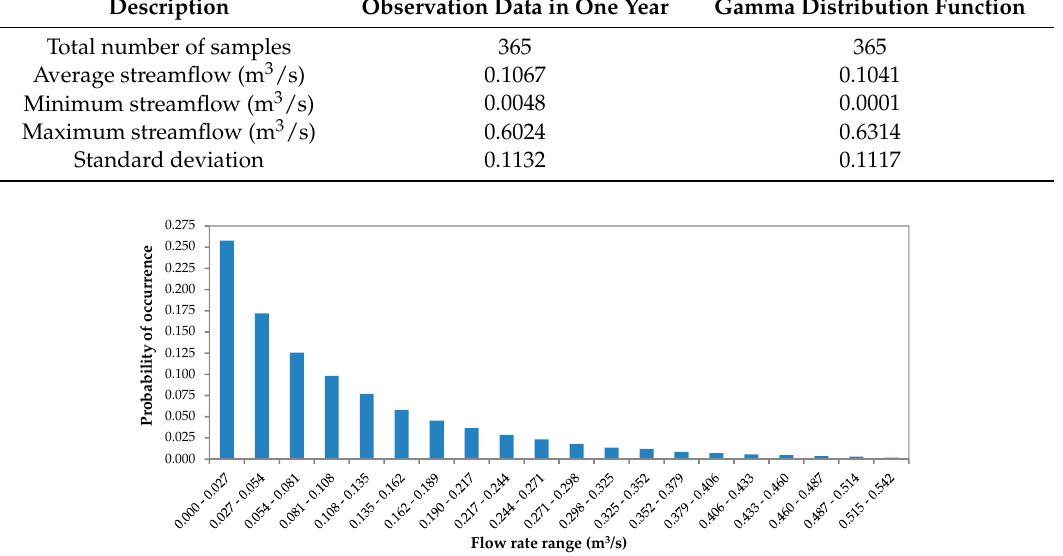
Figure 7. Probability of occurrence of 365 samples in 20 flow rate ranges.